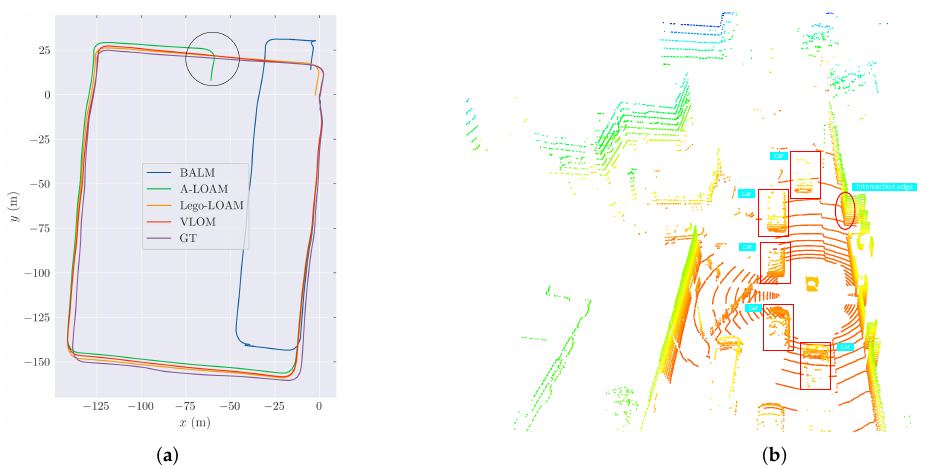
Figure 8. ( a ) compares the estimated trajectories with the ground-truth trajectories in the HK- Data20190117 dataset. Note that all trajectories were aligned to the ground truth according to the EVO library. ( b ) shows a point cloud acquired at the position where A-LOAM begins to fail, which is marked by the circle in ( a